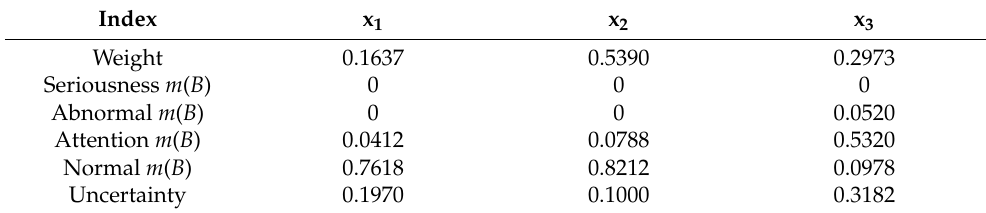
Table 5. Factor layer related